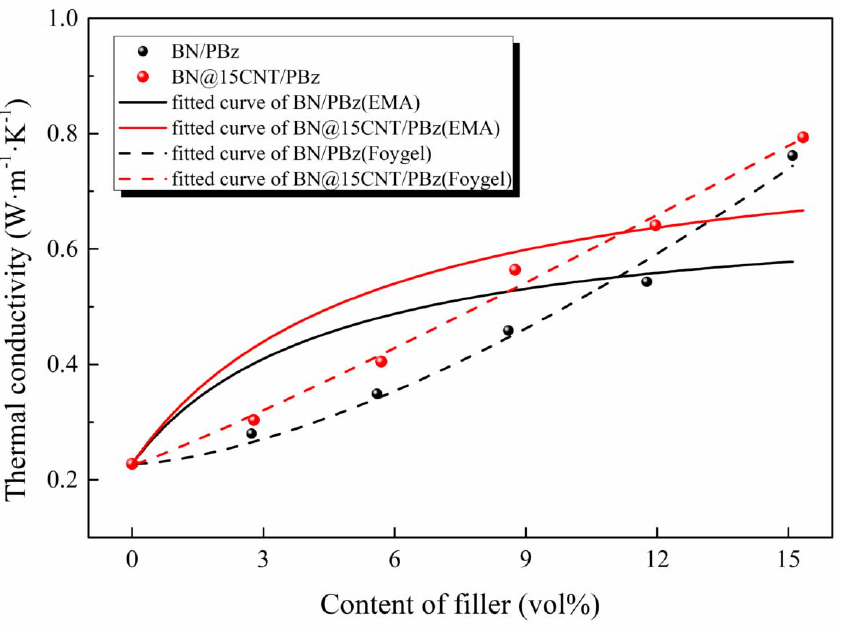
Figure 13. Fitted curves of λ values of BN/PBz and BN@15CNT/PBz composites with the effective medium approximation ( EMA) model and Foygel’s model.